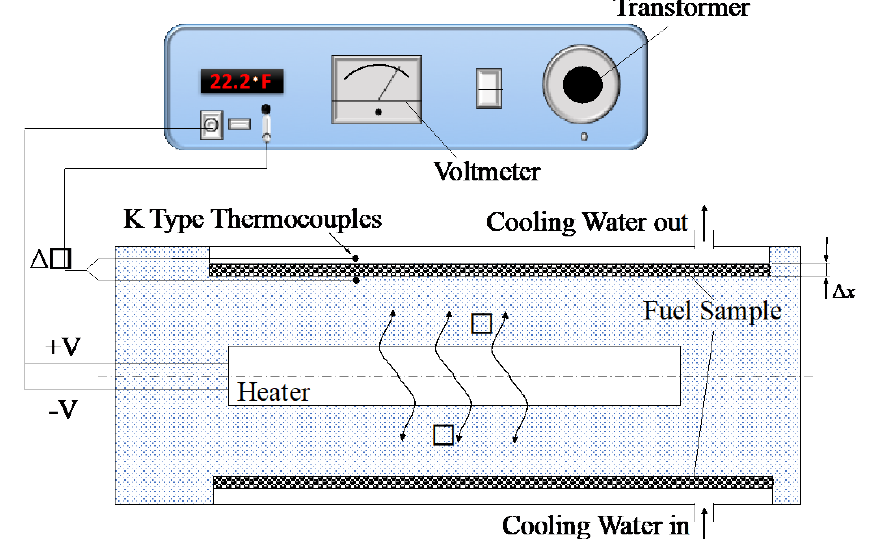
Figure 1. Schematic of thermal conductivity measurement device.